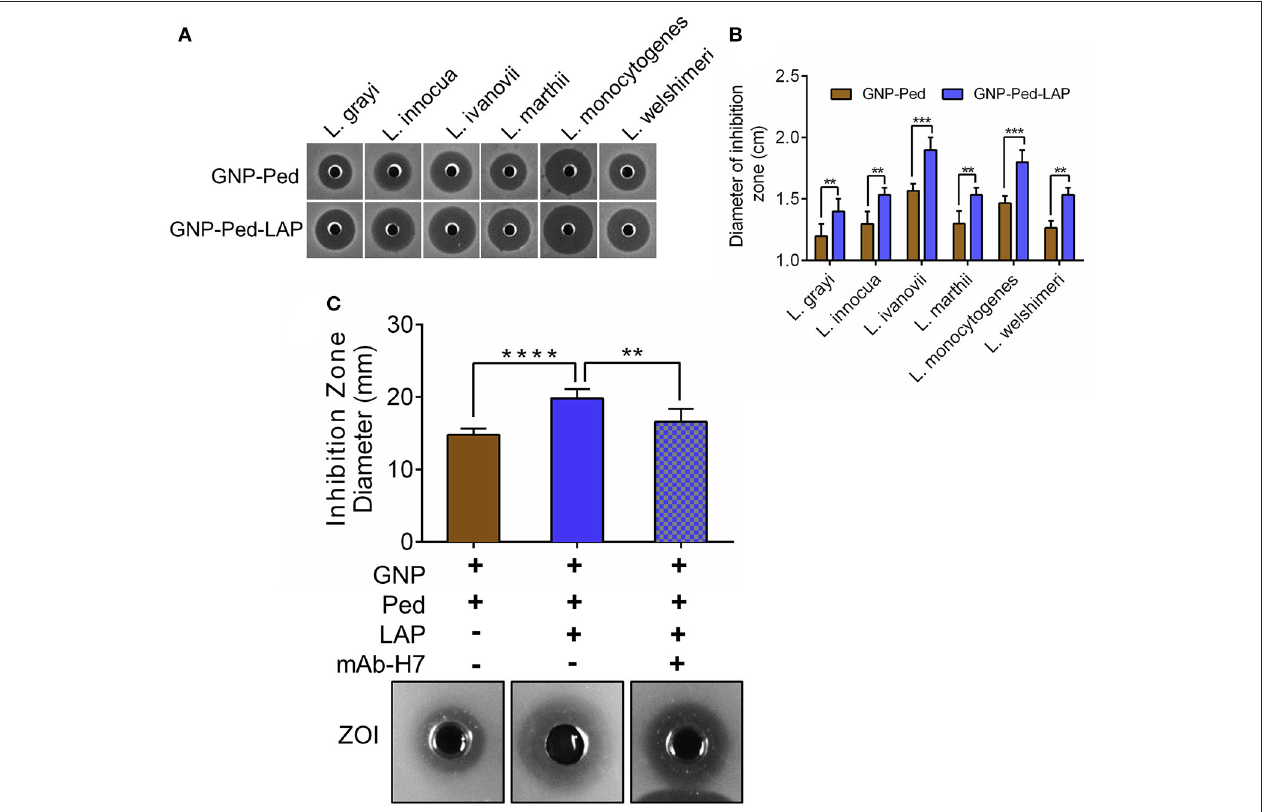
FIGURE 3 | Bioassay based assessment of antilisterial activity of GNP nanoconjugates. Qualitative (A) and quantitative (B) measurement of the diameter of the zone of inhibition (ZOI) caused by GNP-Pediocin and GNP-Pediocin-LAP nanoconjugates against Listeria species. (C) The anti-listerial activity of GNP-Pediocin-LAP